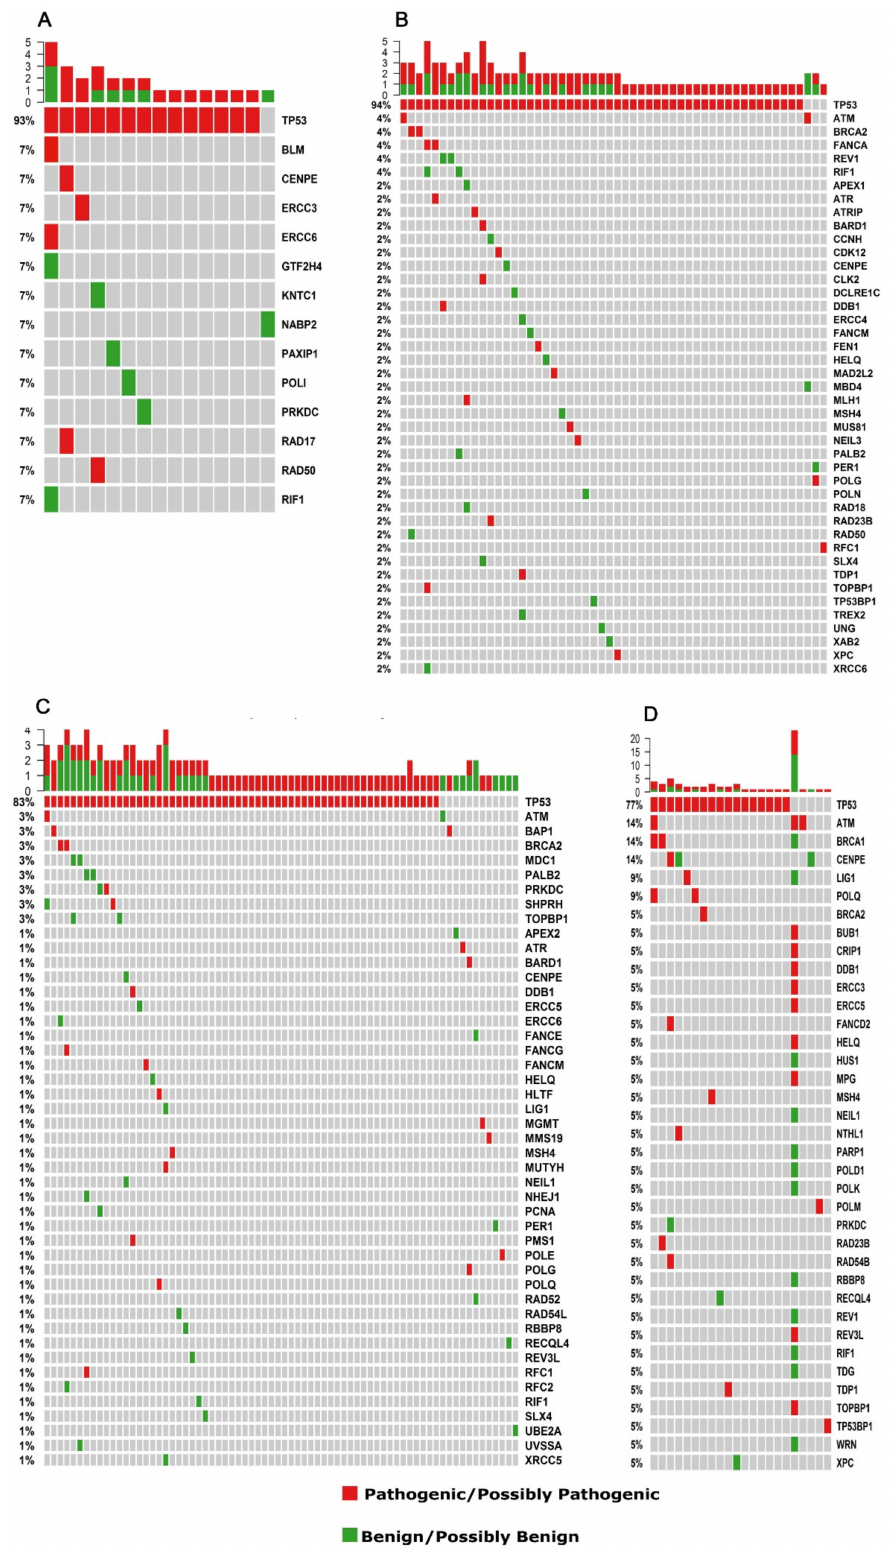
Figure 5. Affected DNA-repair related genes. ( A ) Young HGSOC patients; ( B ) elderly HGSOC patients; ( C ) young TNBC patients; ( D ) elderly TNBC patients. Each column represents a patient, and each line represents a gene. Potentially and possibly pathogenic variants are shown in red, and potentially and possibly benign variants are shown in